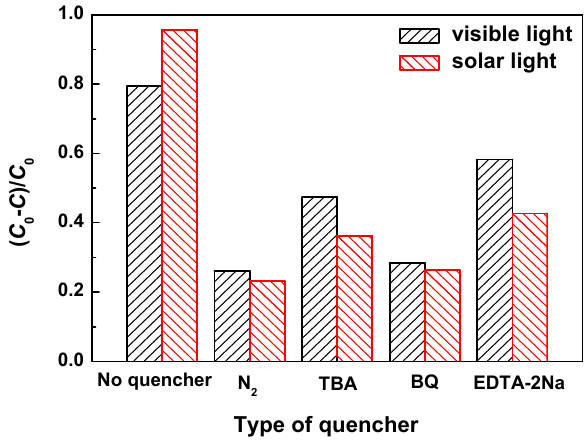
Figure 9. Effects of different quenchers on photocatalytic degradation of RhB with FT3.